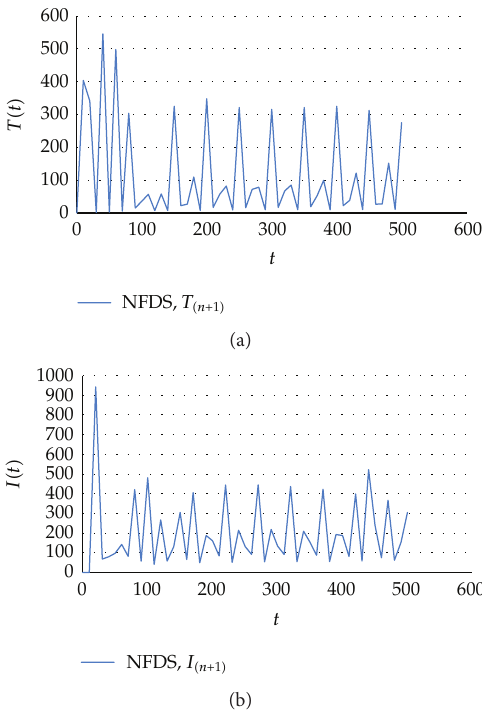
Figure 2: NFDS solutions for 𝑇(𝑡) and 𝐼(𝑡) , 𝑟 = 0.8